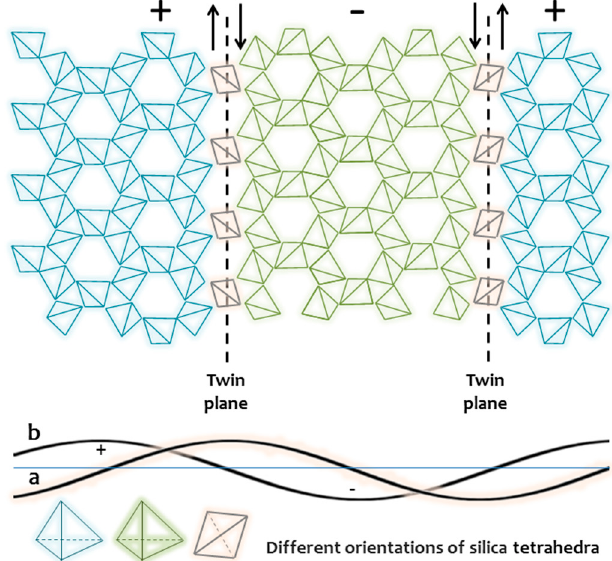
Figure 6. Incommensurate structure of quartz (modified from Putnis [48]). This structure is formed during the transformation from high to low quartz. Both regions of lattice distortion (+ and –) and shear on the Dauphiné twin boundaries ( ↑↓ and ↓↑ ) oscillate. Since the oscillations (represented by the waves a and b) are not an integral multiple of the translational periodicity of the quartz lattice, the structure is termed incommensurate and shows a “periodicity” of ≈ 150 Å.